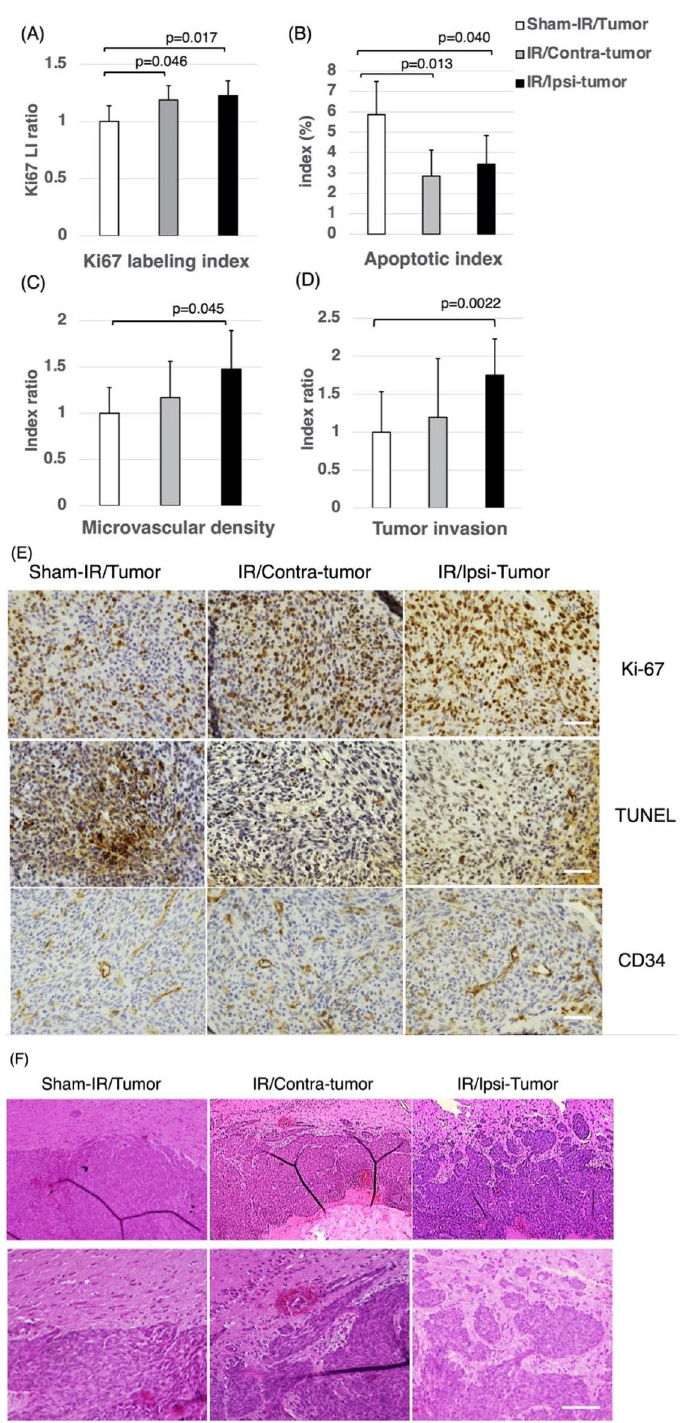
Figure 3. Changes in the biology of the transplanted tumors. ( A ) Ki-67 labeling index. ( B ) Apoptotic index. ( C ) Microvascular density (MVD) index. ( D ) Tumor invasion index. The tumors of the IR/Ipsi-tumor group exhibited significantly higher proliferation, angiogenesis abilities and invasiveness compared to those of the Sham-IR/Tumor group. Tumors of the IR/Ipsi-tumor and IR/ Contra-tumor group showed significantly lower rates of apoptosis compared to the Sham-IR/Tumor group. These results were expressed as mean ± SD and comparisons between groups were assessed by Student’s t-test. ( E ) F98 glioma xenografts were stained immunohistochemically for Ki-67 (upper panels), TUNEL (middle panels) and CD34 (lower panels) at a magnification of × 400. Tumors of the IR/Ipsi-tumor and IR/Contra-tumor group showed a significant increase in proliferative index and a significant decrease in apoptotic index compared to Sham/IR-Tumor group. Tumors of the IR/Ipsi-tumor showed a significant increase in microvascular density index compared to Sham/IR-Tumor group. Scale bars = 50 μm. ( F ) Hematoxylin and eosin staining of F98 tumor showed tumor rim for sham-IR/Tumor (left panels), IR/Contra-tumor (middle panels) and IR/Ipsi-tumor (right panels). The upper panel shows the image at a magnification of × 80, and the area surrounded by the square shows the image at a magnification of × 200 (lower panel). Scale bars = 100